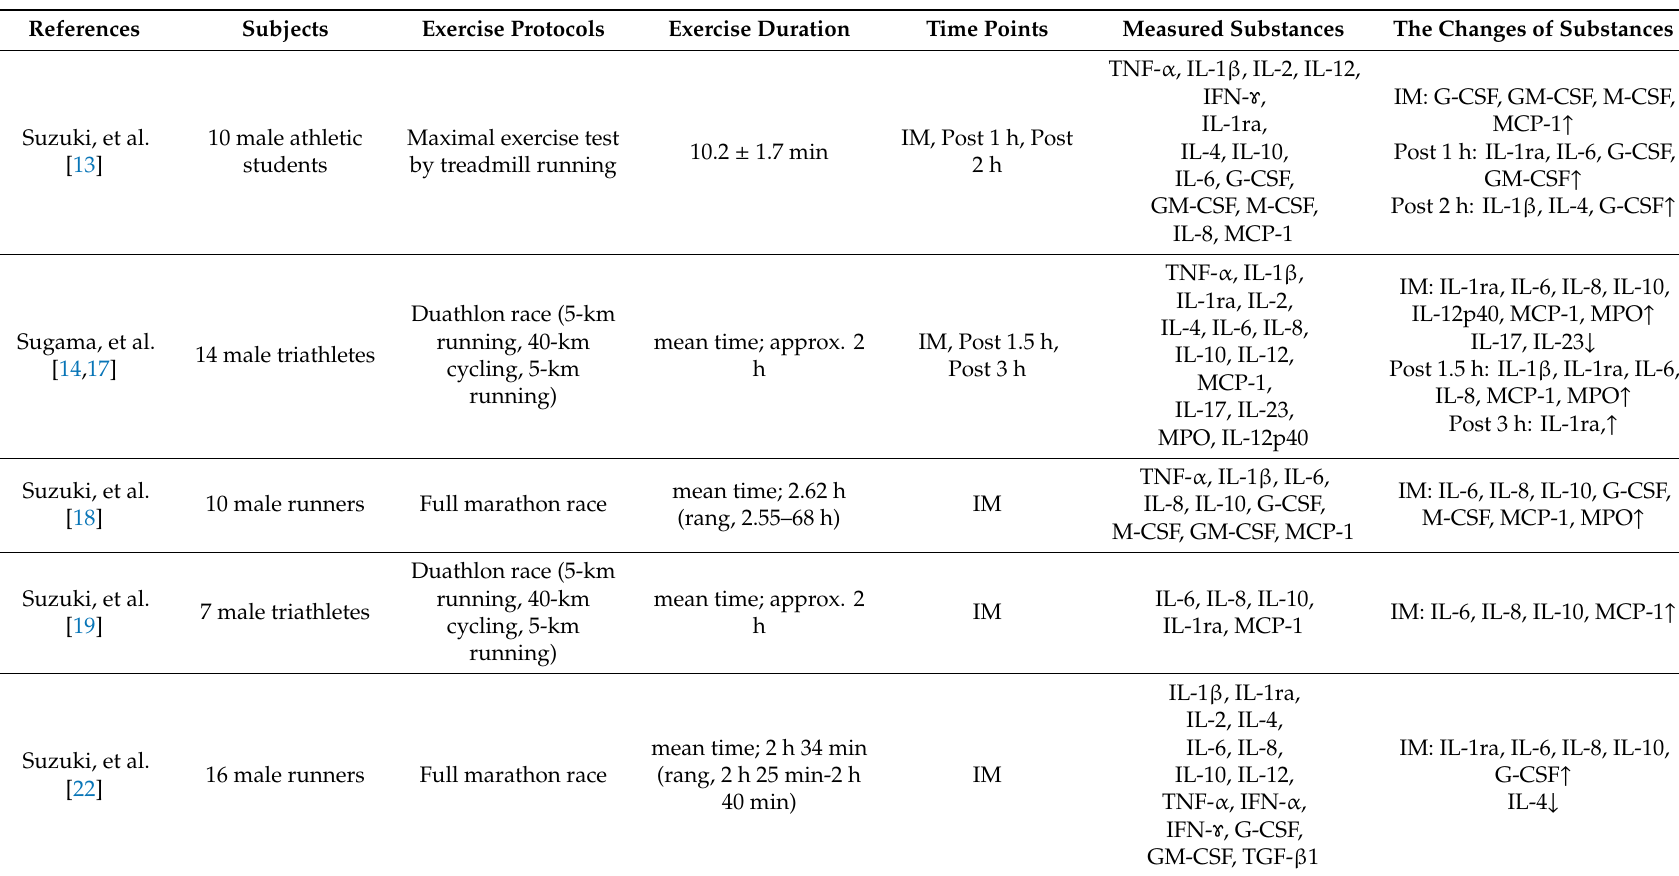
Table 1. The specific reports on the change of circulating cytokines, chemokines and immune cell activation markers following exercise in di ff erent research groups including